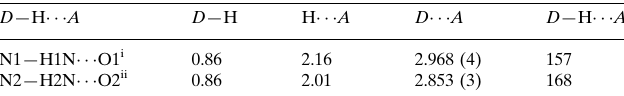
Hydrogen-bond geometry (A˚ , (cid:1)